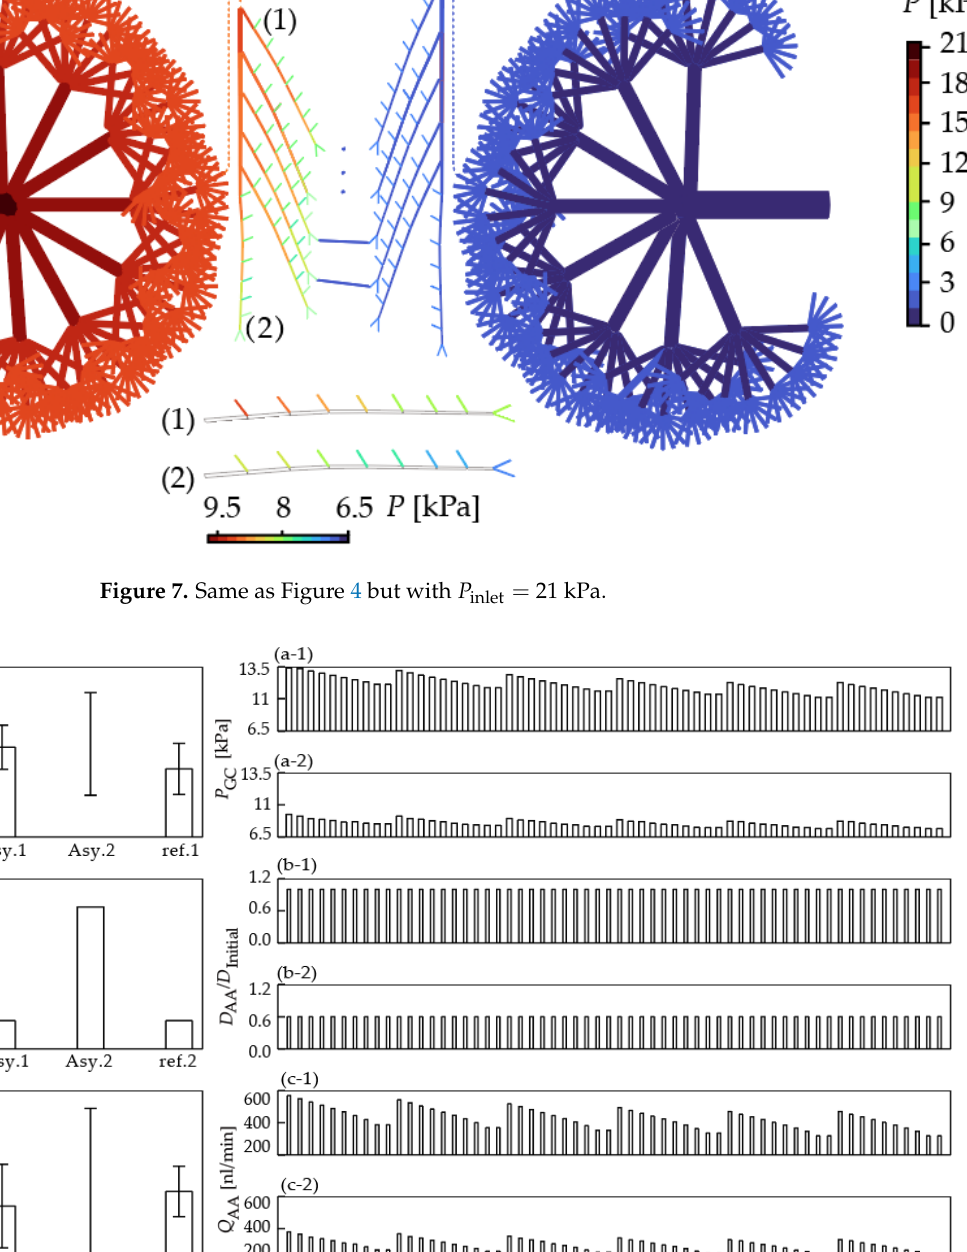
Figure 8. ( a ) Glomerular pressure, P GC , ( b ) rate of change in AA diameter, D AA / D initial , and ( c ) AA flow rate, Q AA , of the asymmetrical model with the myogenic response (Asy. 1 ) and the asymmetrical model without the myogenic response (Asy. 2 ). Mean value and the detailed distribution of a group of AAs are illustrated in the left and right panels (( a-1 ), ( b-1 ) and ( c-1 ) of Asy. 1 ; ( a-2 ), ( b-2 ) and ( c-2 ) of Asy. 2 ), respectively. Same as Figure 4 but with P inlet = 21 kPa. Reference data from experimental measurements are shown as: Ref.1: Figure 4 from Ofstad and Iverson [38]; Ref.2: Figure 3 from Loutzenhiser et al. [39]; Ref.3: Table 2 from Iverson et al.